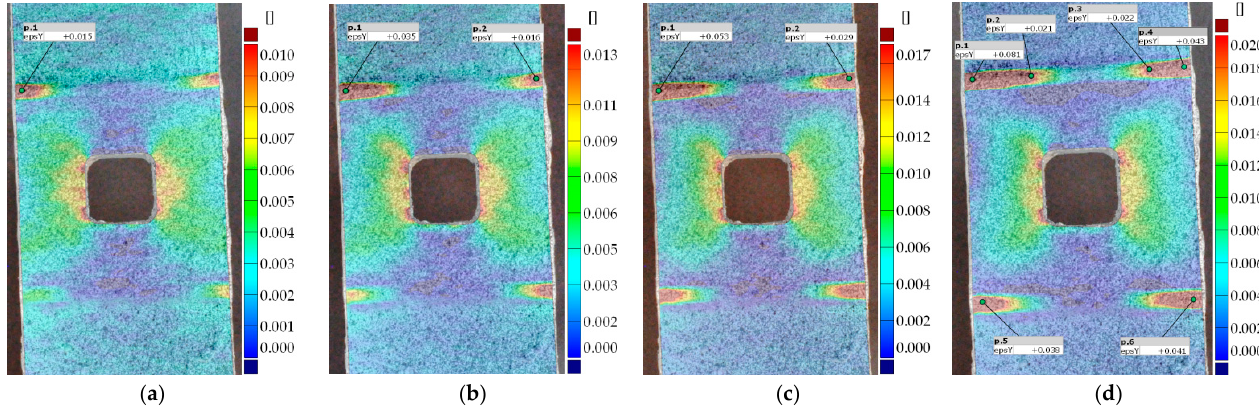
Figure 16. Distribution of strain on surface for sample no. 5 with rectangular holes with a fillet radius of R2 and composite overlays for strain: ( a ) ε TOT = 0.22%; ( b ) ε TOT = 0.27%; ( c ) ε TOT = 0.32%; ( d ) ε TOT = 0.37%.